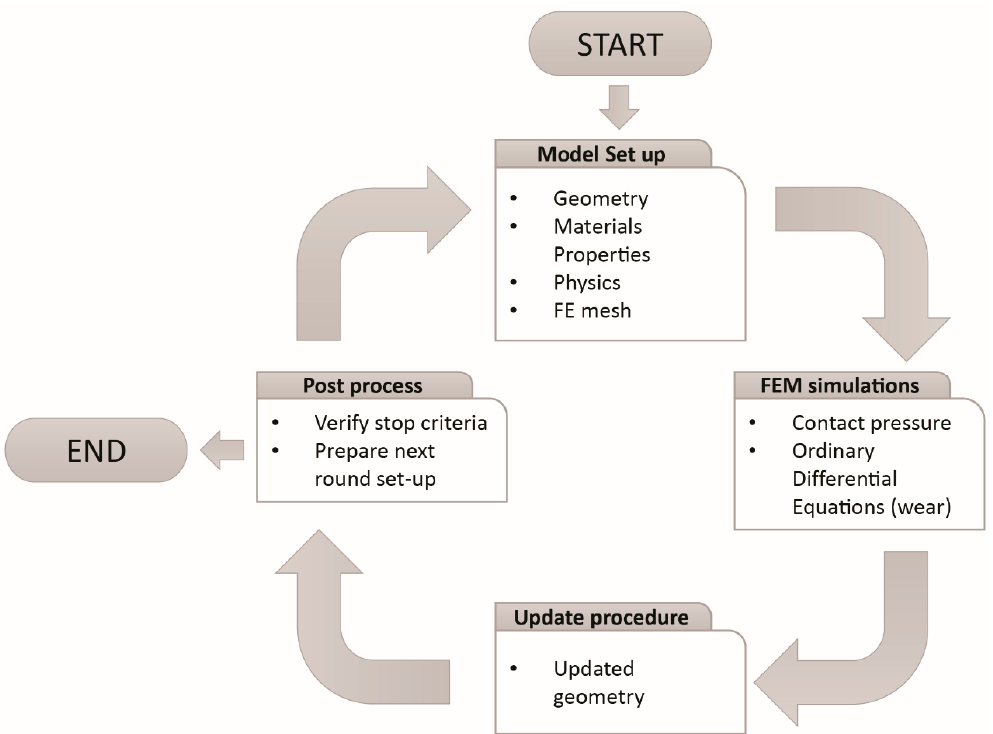
Figure 3. Typical finite element metho and boundary element method simulation steps for tribology.